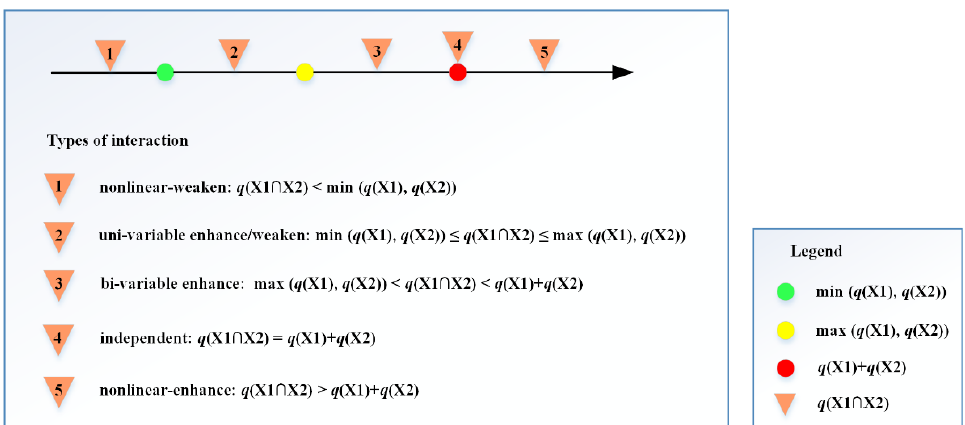
Figure 3. Judgment for interaction types between explanatory variables. Note: max() and min() denote the maximum and minimum functions, respectively. q (X1 ∩ X2) represents the interaction between factors X1 and X2. Modified from prior research [38,57,58].